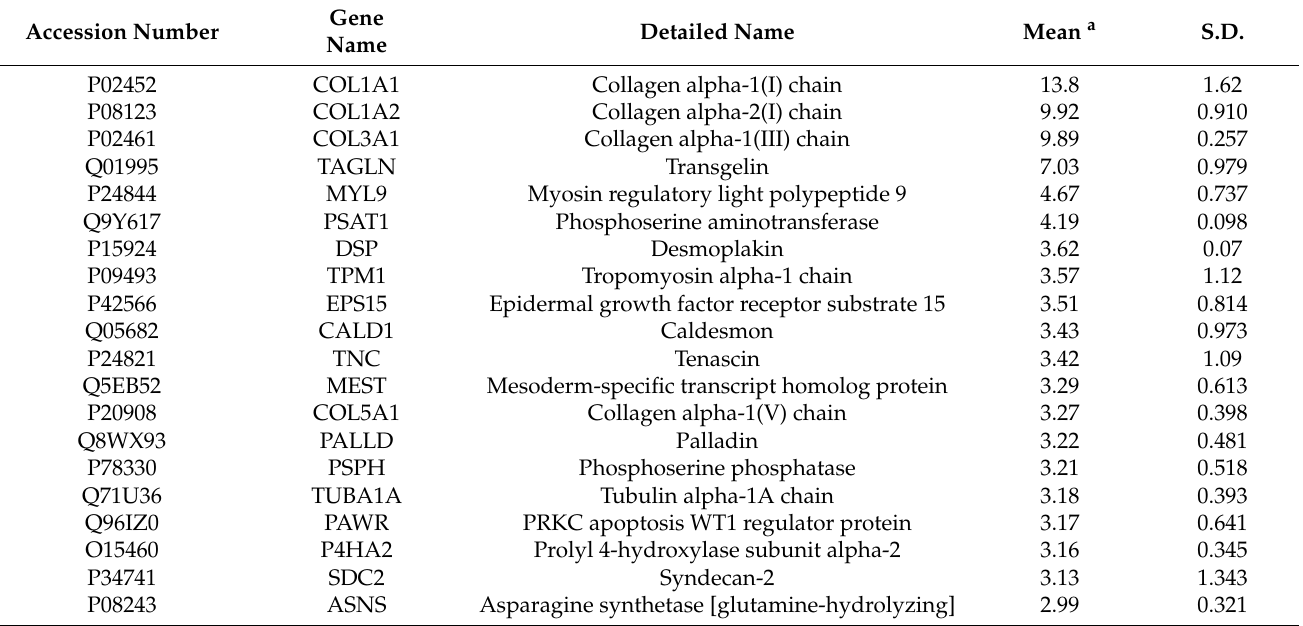
Table 1. Top-20 of the 51 proteins enriched in solo-cultured hBP. The complete list is available in Table